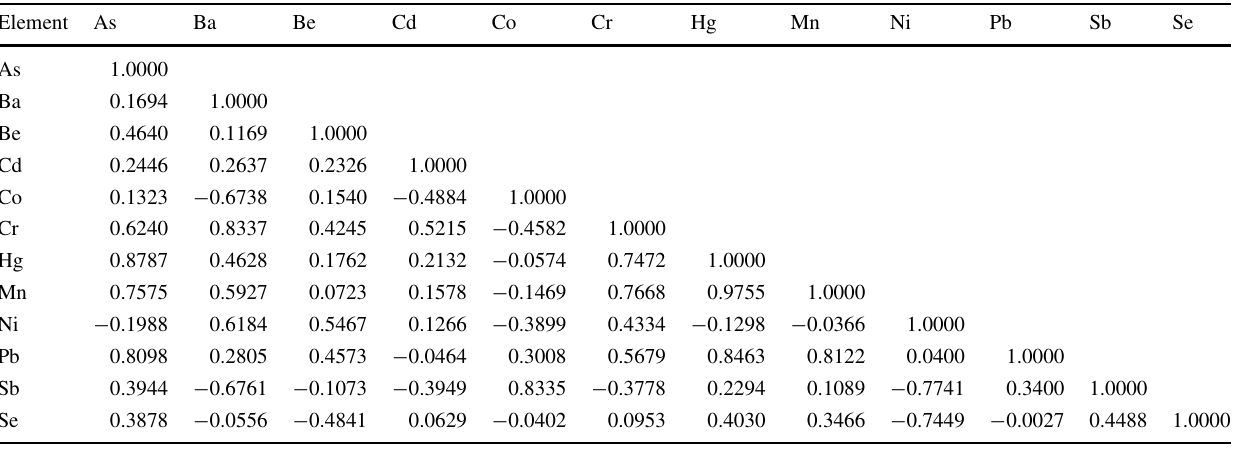
Table 6 Correlation coefficients for the trace elements in the No.14 coal from the Huolinhe mine Element As